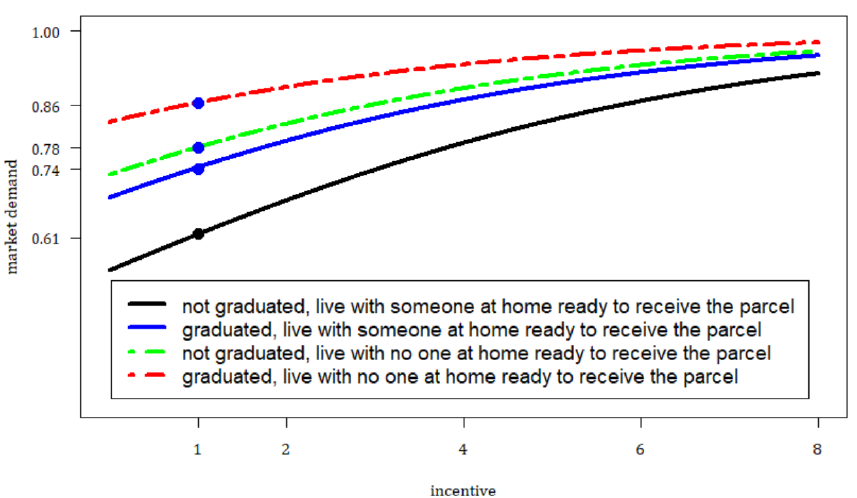
Figure 3. Scenario II–base scenario with 500-meter distance.